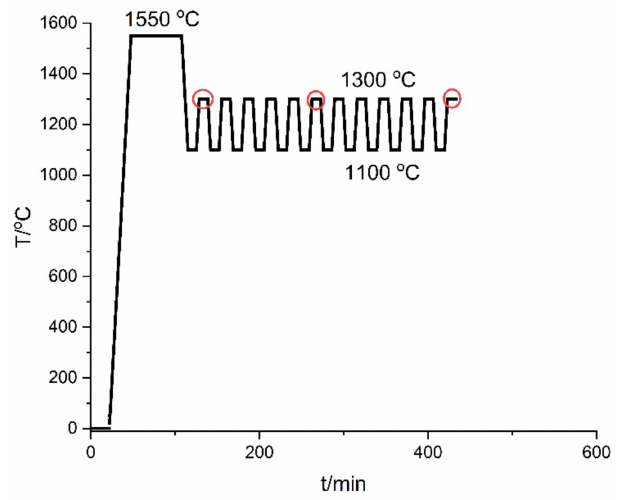
Figure 2. The typical temperature profile in a resistance